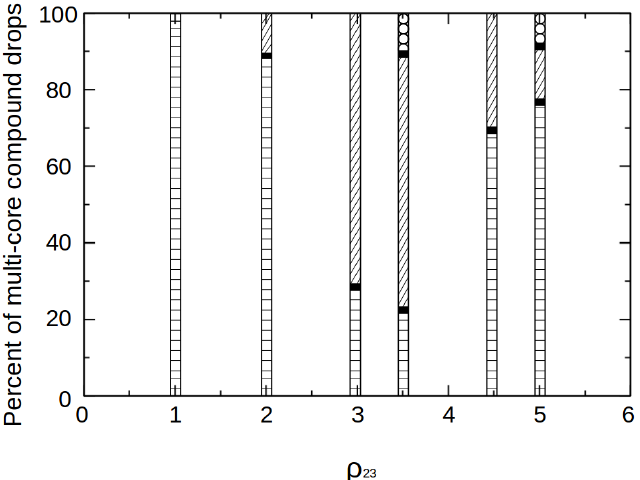
Figure 8. Percent of multi-core compound drops formed vs intermediate-to-outer density ratio. The horizontal and slant lines depicted in this plot correspond to 1-core and 2-core compound drops respectively whereas circles denote 3-core compound drops